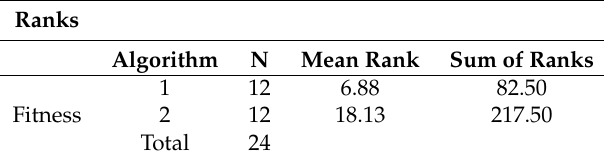
Table 4. Mann–Whitney U-test statistics on the performance of BCSO and BPSO.